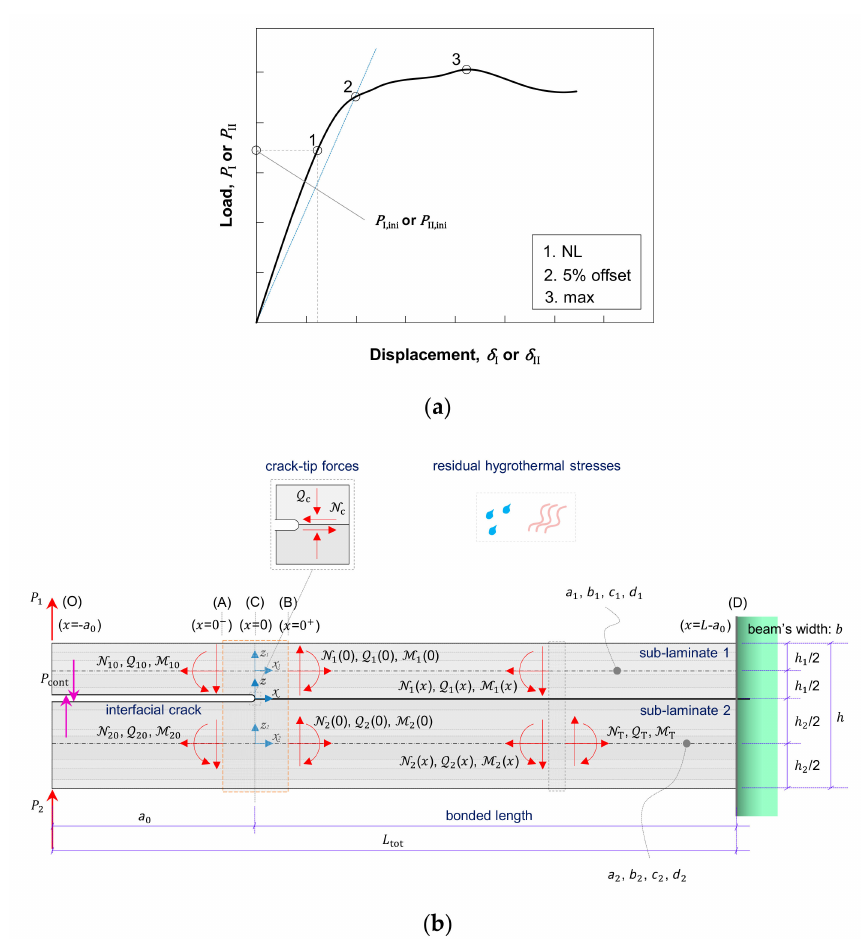
Figure 5. ( a ) An example load–displacement curve from a double cantilever beam (DCB) / end-notched flexure (ENF) test and determination of the crack initiation load following the three criteria defined in the ASTM D5528 standard. ( b ) Schematic representation of the beam model [2] utilized for experimental data reduction. We use a cantilever beam consisting of an elastic and laminated material that, due to the presence of an asymmetric through-the-width crack (i.e., delamination or interfacial disbonding), is split into two sub-laminates with thicknesses h 1 and h 2 and arbitrary stacking sequences. The beam is loaded at its left end by concentrated and vertical loads (i.e., the loads P 1 , P 2 , and P cont , where P cont is the contact force between the upper and lower unbonded arms of the beam). The beam is also stressed by residual hygrothermal stresses. b , L tot , and a 0 are the beam’s width (not shown in the figure), total length, and initial crack length, respectively. N c and Q c are the crack-tip forces, and N i , Q i , and M i , i = 1, 2, are the internal forces and moments developed at various cross-sections of the